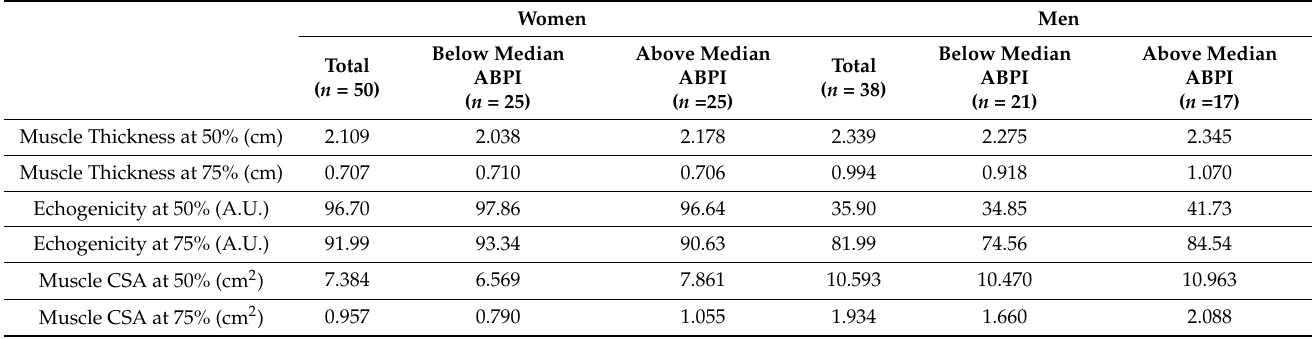
Table 2. Rectus femoris muscle thickness, echogenicity, and cross-sectional area assessed via ultrasonography captured using the panoramic feature at 50% and with regular B-mode images at 75% of the right leg in 88 middle-aged men and